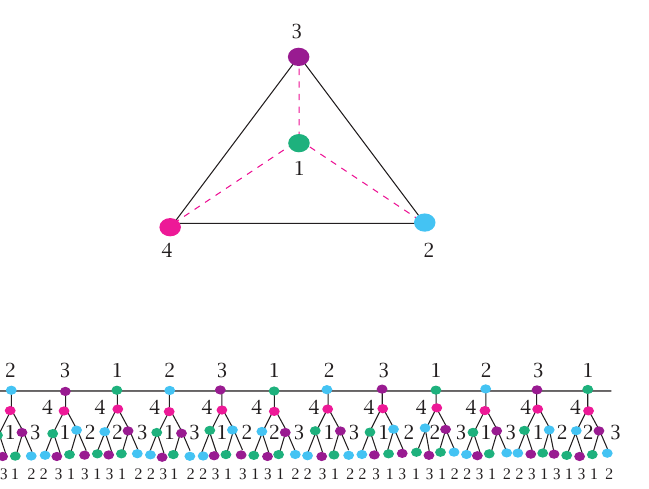
Figure 3.1 . Tessellation of the 3-regular tree from the complete graph on 4 vertices ( K 4 or the tetrahedron). Obtain the tessellation by choosing a spanning tree in K 4 —the dashed edges. Repeat the spanning tree for each of the infinitely many sheets of the cover. Connections between sheets are forced by the ordering of points on the geodesic labelled with 1, 2, 3 repeated infinitely many